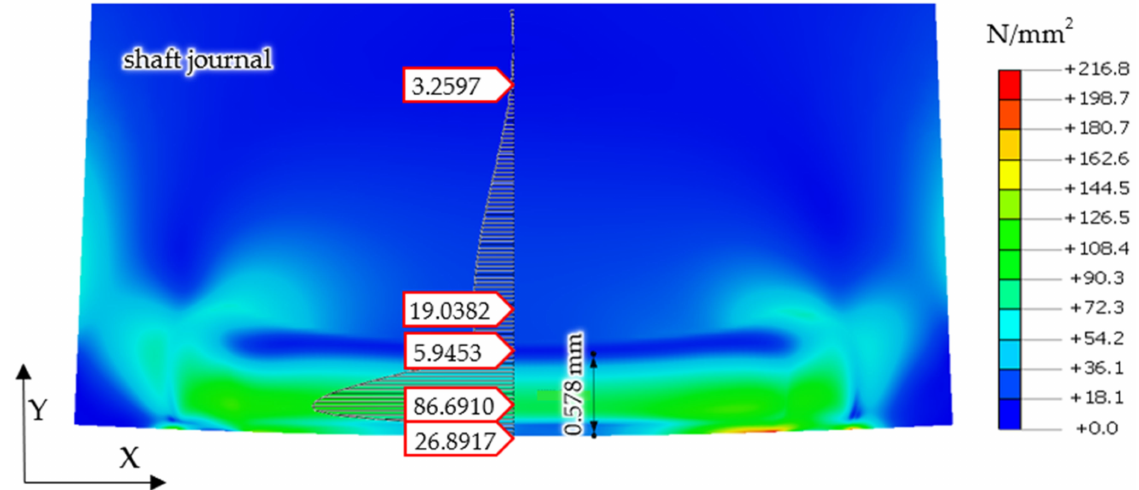
Figure 18. Distribution of permanent stress values in the surface layer of the steel shaft journal with actual journal profile No. 10, after this profile has been turned over the support roller made of